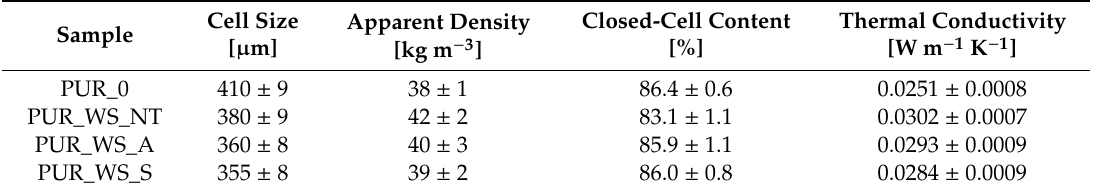
Table 5. Structural parameters and thermal conductivity results of PUR